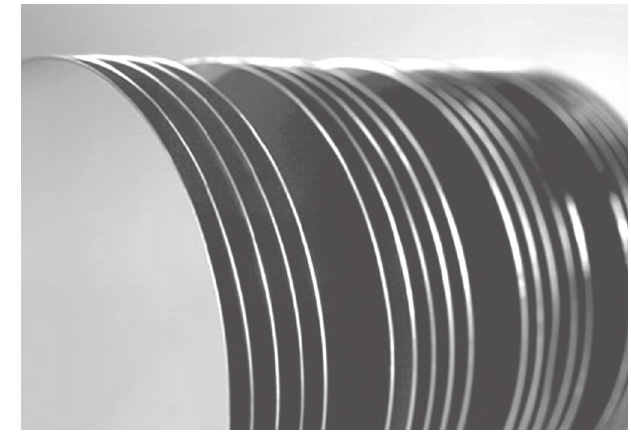
Figure 1. Picture shows diamond crystals synthesized on a silicon substrate by CVD (SEM image reproduced with permission from Adamant Technolo- gies - Switzerland).